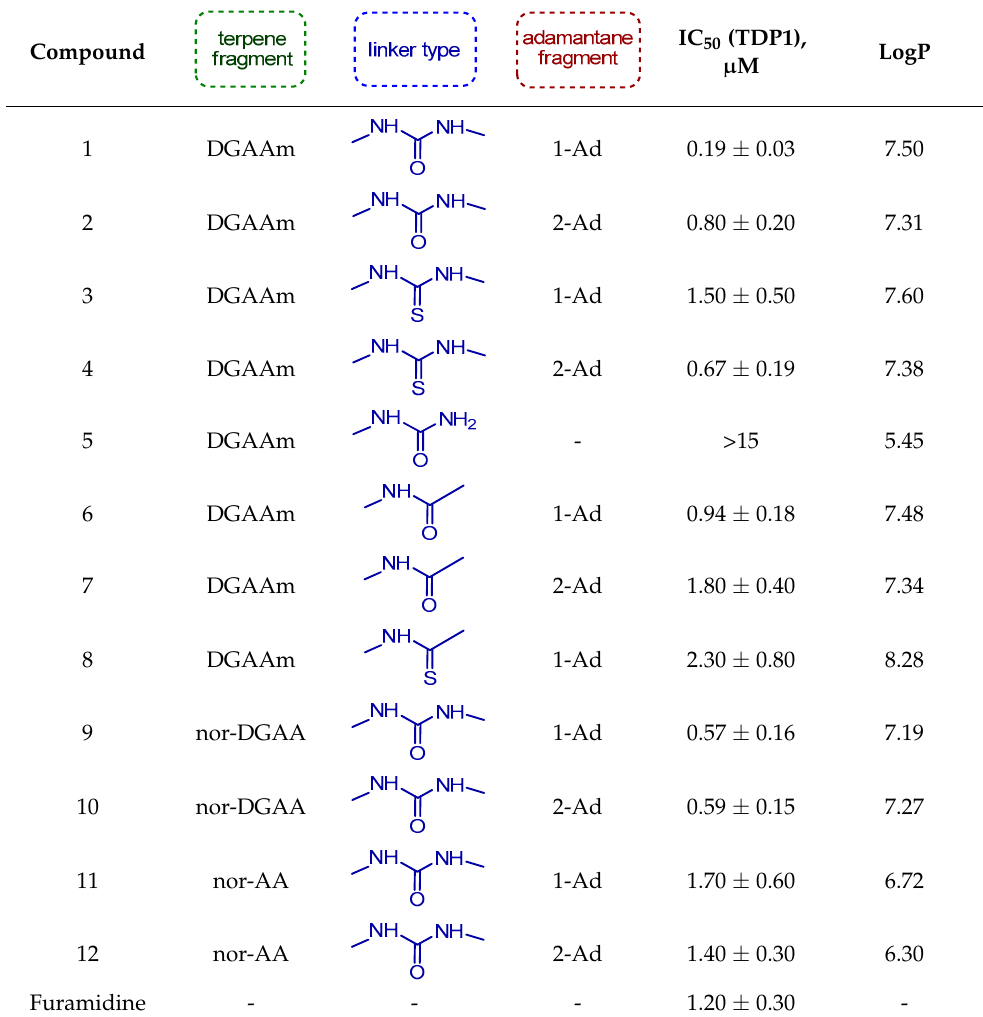
Table 1. Inhibitory activity of compounds 1 – 12 against TDP1 and predicted LogP (main determinant of brain tissue binding).